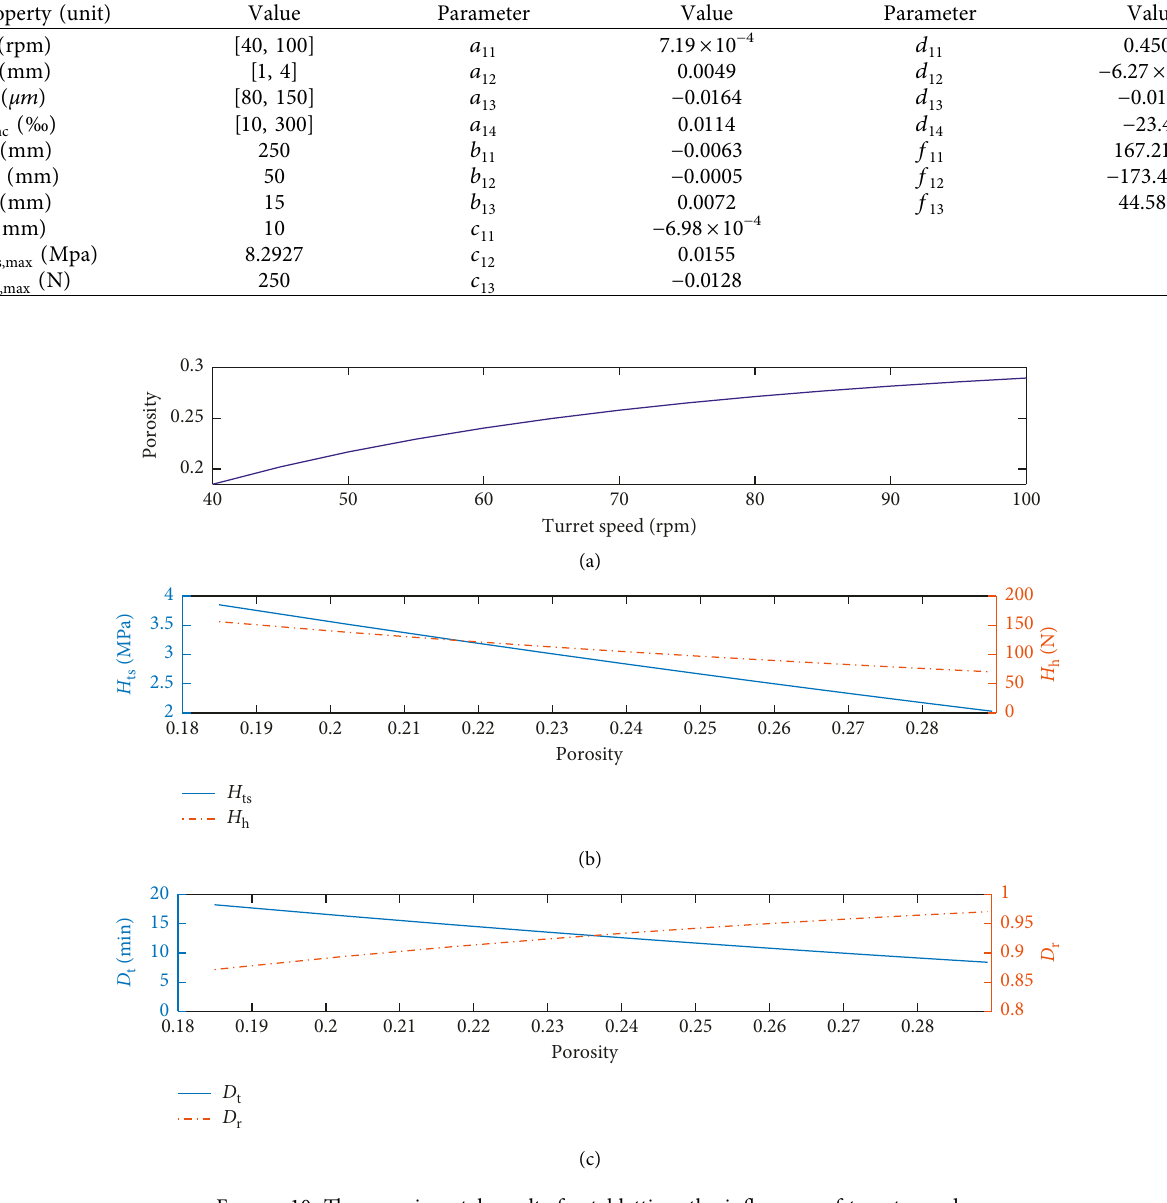
Figure 10: The experimental results for tabletting: the influences of turret